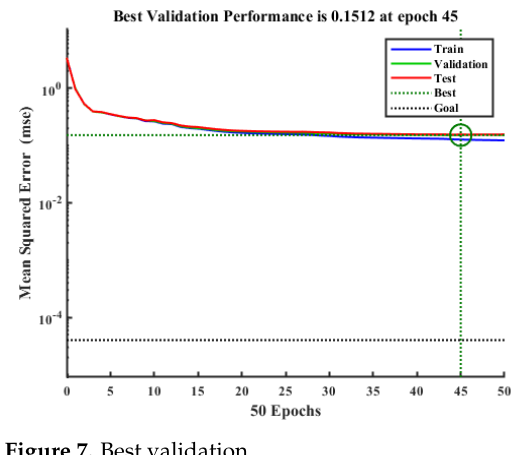
Figure 7. Best validation.